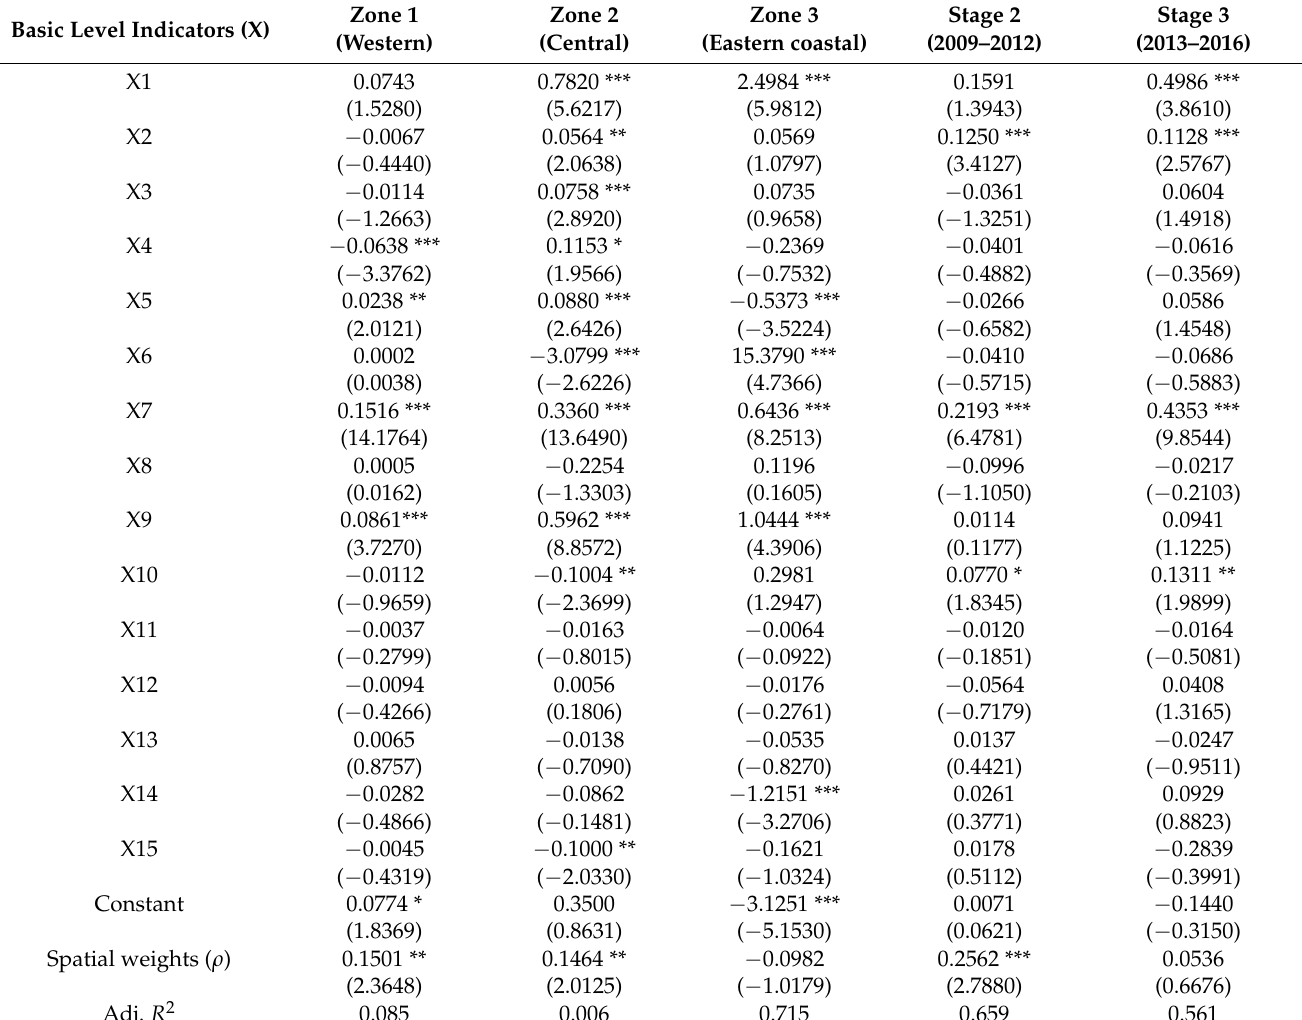
Table 7. Sub-models of land finance at the temporal scale and the spatial